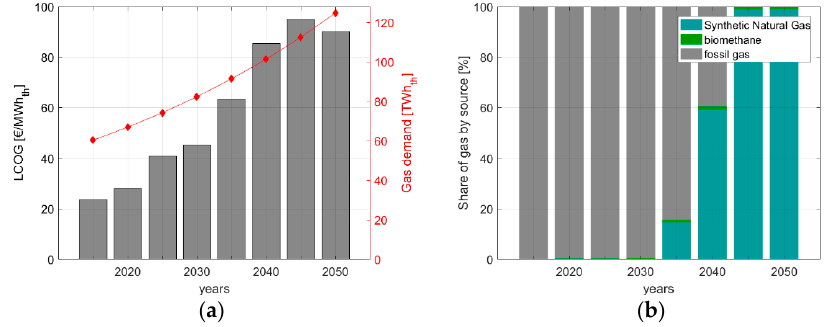
Figure 12. The increase in industrial gas demand (red line) and the variation in levelised cost of gas (LCOG) (grey bars) ( a ) and gas in the system by source ( b ) from 2015 to 2050.